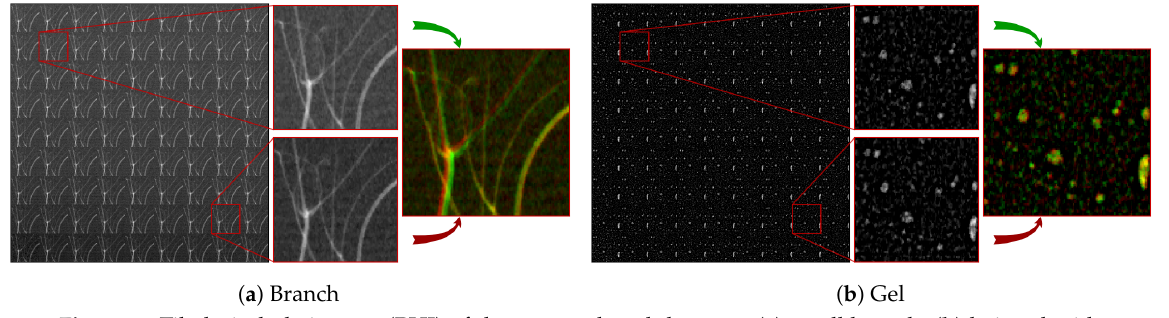
Figure 8. Tiled pin-hole images (PHI) of the two analyzed datasets: ( a ) small branch; ( b ) hair gel with air bubbles. Both of the figures include the magnification of two different PHIs. The two PHIs are then combined into an RGB image, in order to better show their differences. The top image contributes to the green channel, and the bottom image to the red